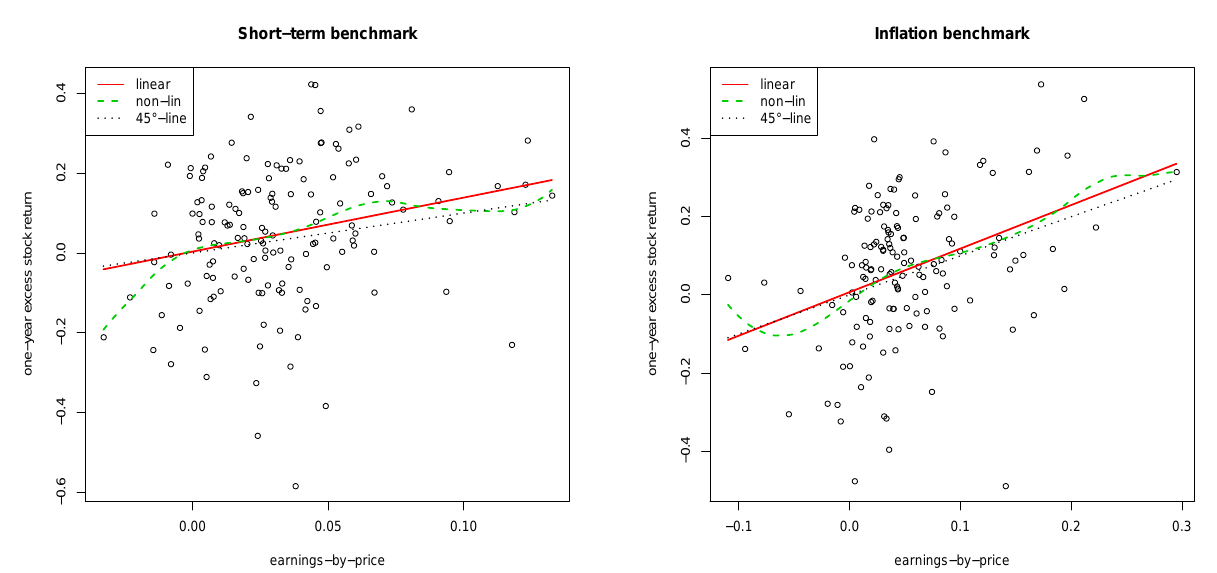
Figure 4. Relation between excess stock returns and the earnings-by-price ratio. ( Left ) Short-term interest rate benchmark. ( Right ) Inflation benchmark. Shown are estimates of a linear function (solid red), the local-linear smoother (dashed green), and the 45 ◦ -line (dotted black). Period: 1872–2020. Data: annual S&P 500.